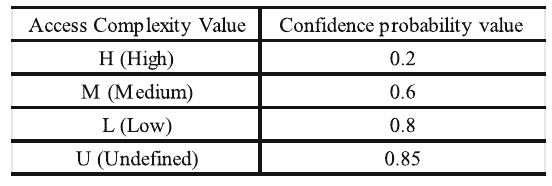
Table 9 Reference table for the probability of atomic attack